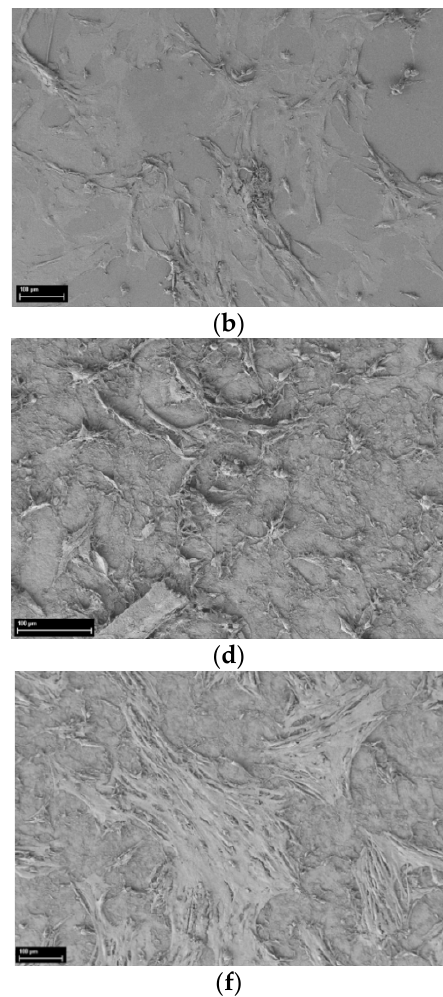
Figure 7. SEM images of the scaffolds after 96 h of mouse mesenchymal stem cells cultivation. ( a , b ) The reference sample (cover glass); ( c , d ) bare BC film; and ( e , f ) BC with 5 wt.% of CeO 2 nanoparticles.